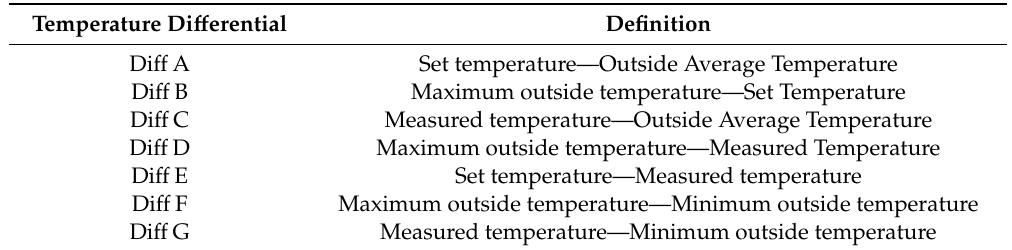
Table A6. Temperature di ff erentials for energy consumption analysis.